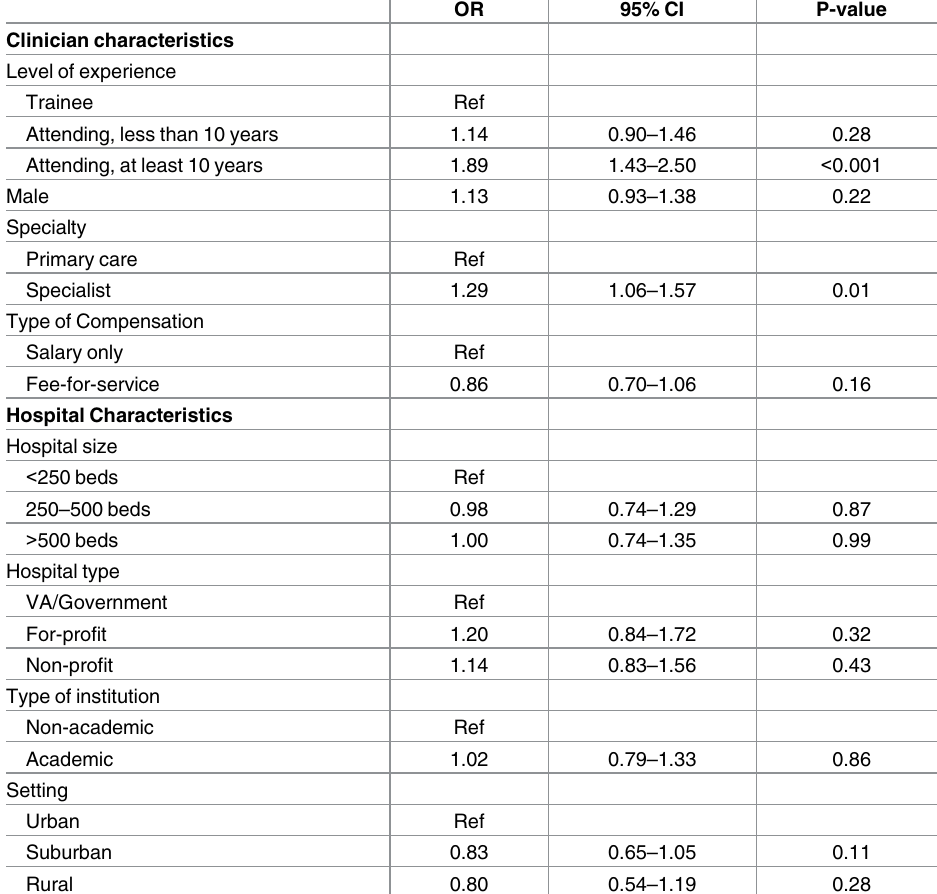
Table 3. Characteristics of physicians who believed that a greaternumber of physicians perform unnecessary procedures when they profit from them (N = 2,106).